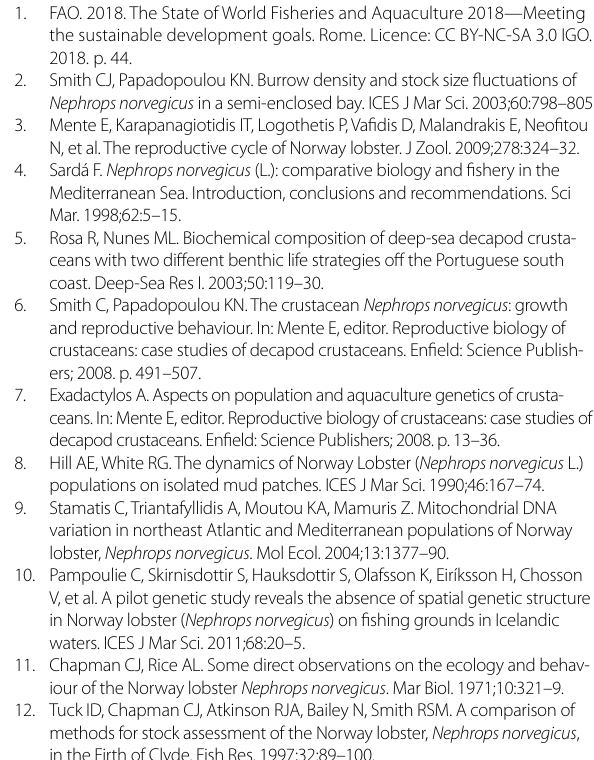
Additional file 1: Table S1. Number of individuals per gender and month. Figure S1. Factorial Correspondence Analyses for all individuals. Result suggest a single